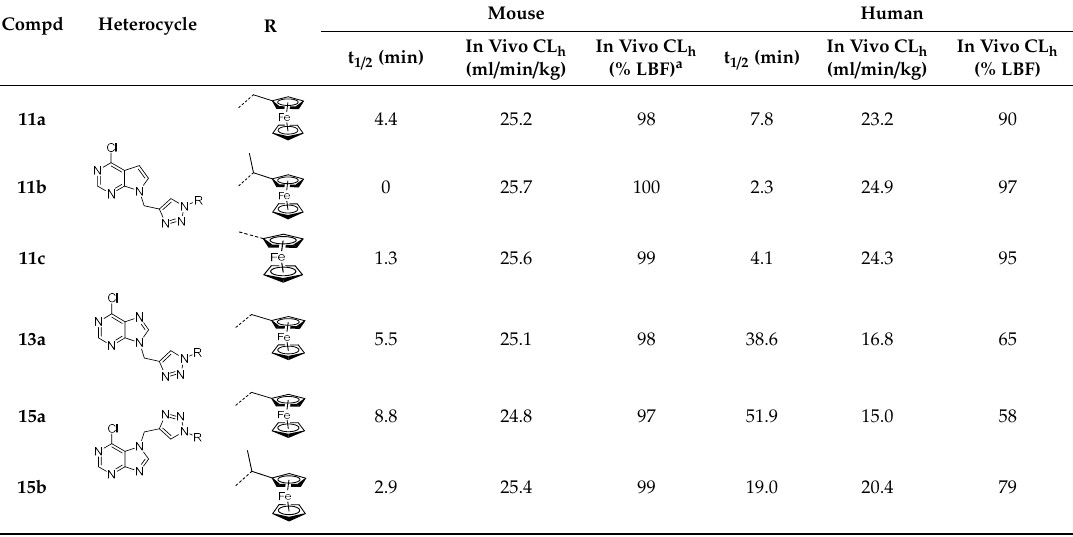
Table 3. Metabolic stability parameters of 11a − 11c , 13a , 15a , 15b in mouse and human liver microsomes. Compd